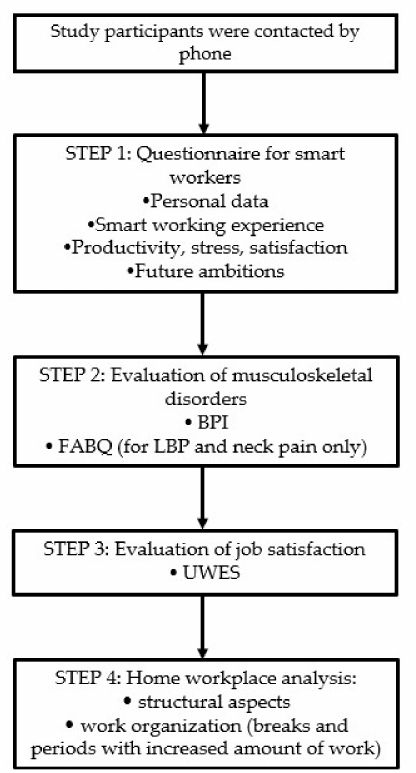
Figure 1. Flow chart of the evaluation